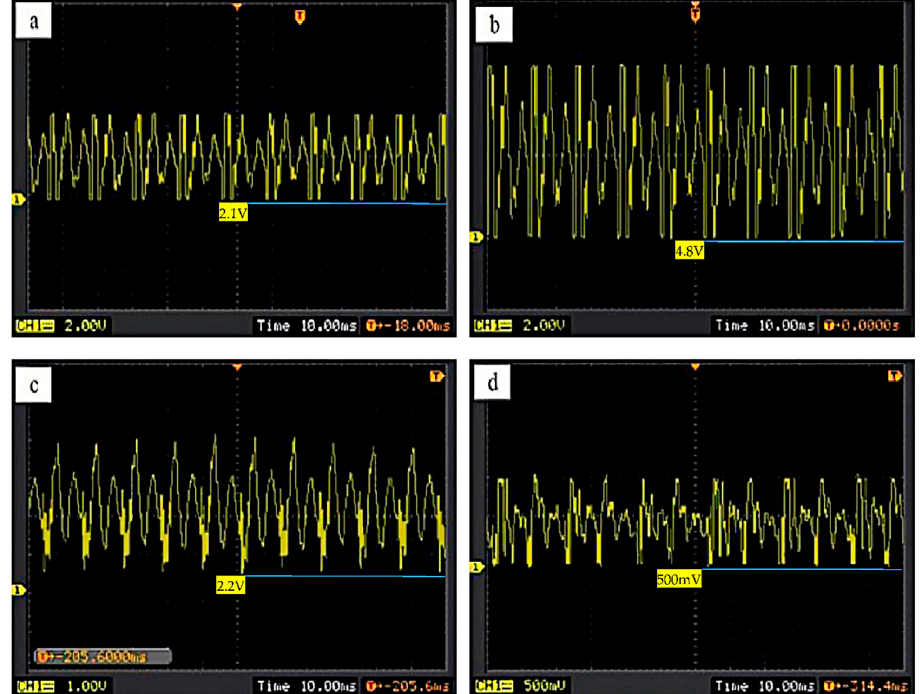
Figure 15. Piezoelectric signal of the fiber membrane at different addition of FeCl 3 ·6H 2 O: ( a ) the addition of 0.4 wt%; ( b ) the addition of 0.8 wt%; ( c ) the addition of 1.2 wt%; ( d ) the addition of 1.6 wt%. Table 7. Piezoelectric signal of the fiber membrane at different loading of AgNO 3.